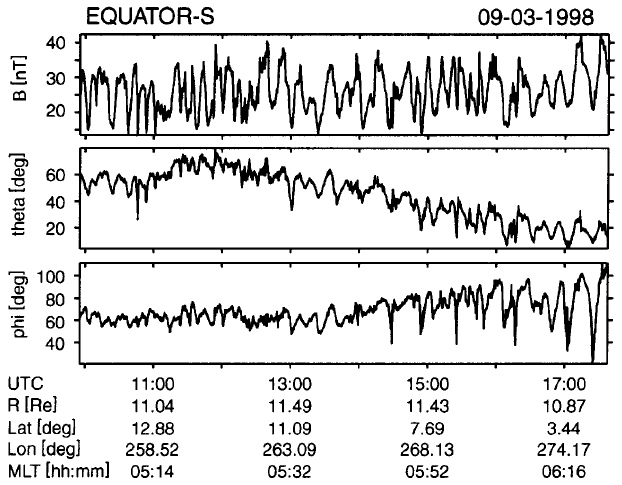
Fig. 1. Large-amplitude fluctuations of magnetic field strength and orientation near the apogee of Equator-S during early morning